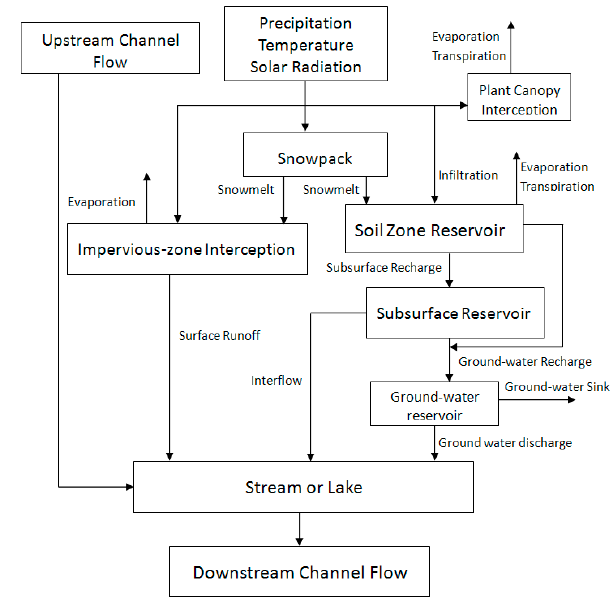
Figure 3. Schematic diagram of a watershed and its climate inputs simulated by the Precipitation-Runoff Modeling System